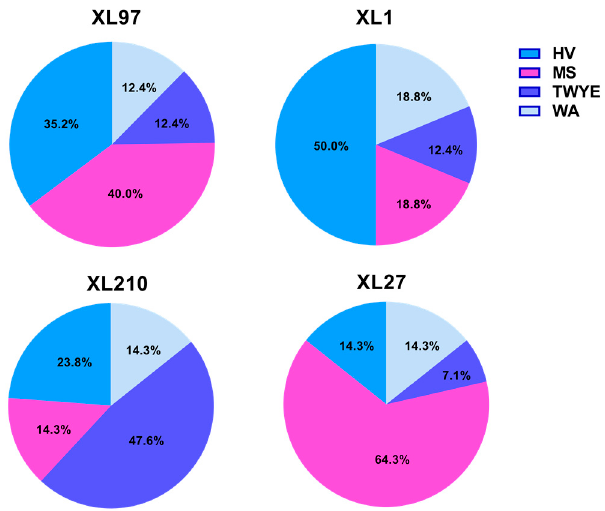
Figure 1. Numbers of endophytic actinobacteria isolated from different media across four different C. oleifera samples (HV: humic acid vitamin B agar; MS: mannitol soybean agar; TWYE: tap water yeast extract agar, WA: water agar medium).